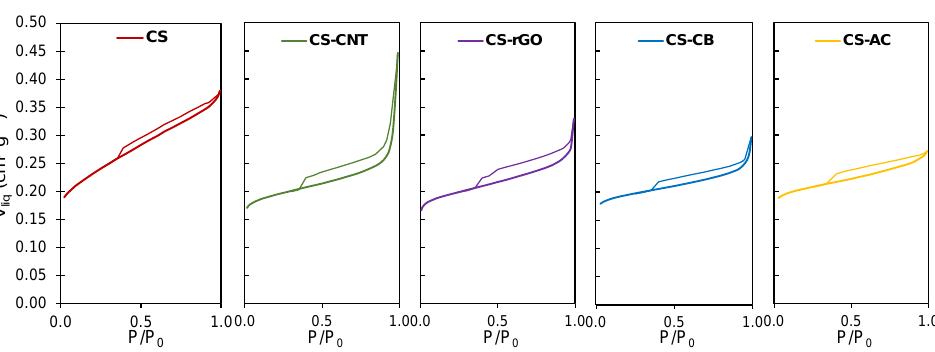
Figure 3. FTIR-spectra before and after thermal carbonization of some selected samples. The nature and dispersion of Pt-nanoparticles in the Pt/carbon catalysts were deter- mined by both X-ray powder diffraction (XRD) and transmission electron microscopy (TEM) analysis (Figures 4 and 5, respectively). All XRD patterns showed a wide band at around 23° corresponding to the (002) lattice of graphite (JCPDS Card 89-8487), showing that carbon supports present a certain structural ordering in spite of being mainly amor- phous materials. Regarding the oxidation state of Pt-phase (Figure 4), only Pt 0 was de- tected in the catalysts after reduction, as pointed out by XRD peaks placed at 2 θ = 39.7°, 46.2°, 67.2° and 81.0° associated to the (111), (200), (220) and (311) crystal planes of Pt 0 (JCPDS Card 04-0802). The most intense diffraction peaks were observed for Pt/CS-AC.